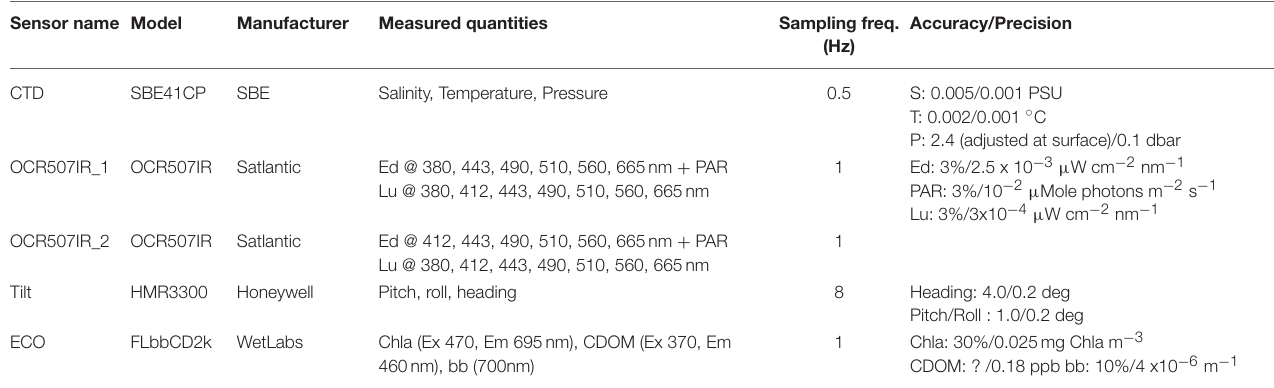
TABLE 1 | ProVal sensor characteristics. Sensor name Model